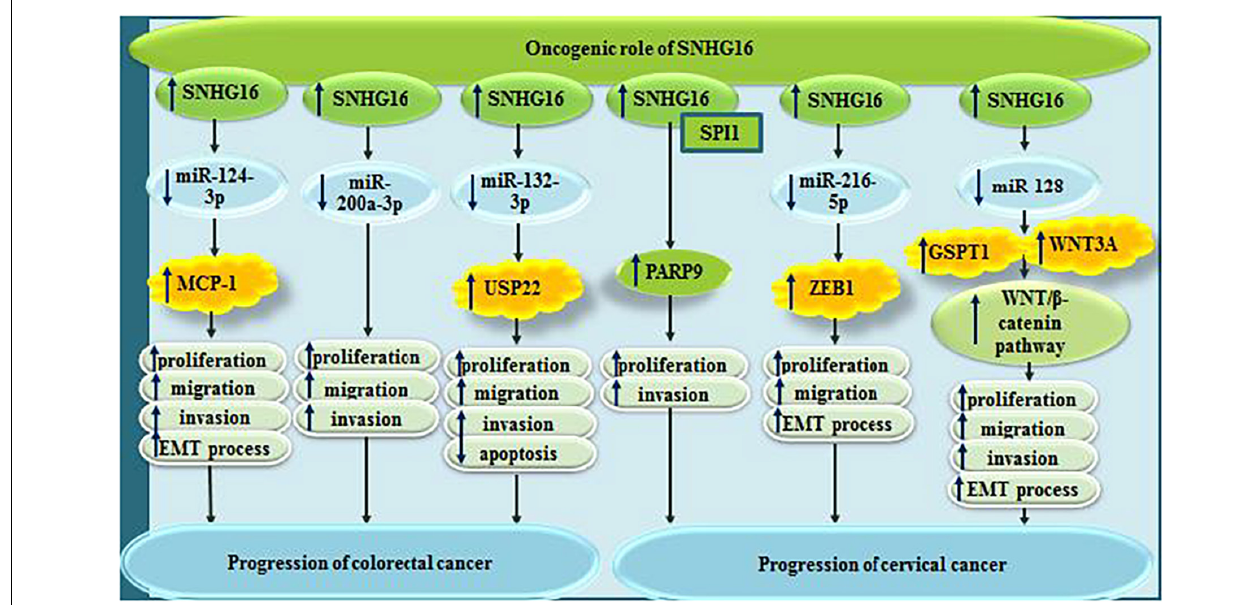
FIGURE 6 | Oncogenic roles of SNHG16 in colorectal and cervical cancers.